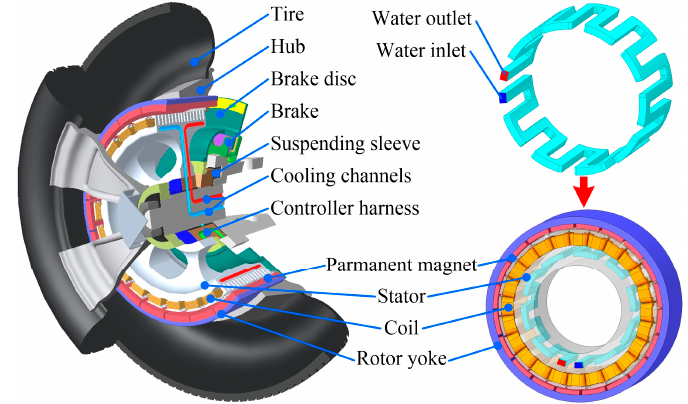
Figure 1. Structure of the integrated PM-IWM prototype.